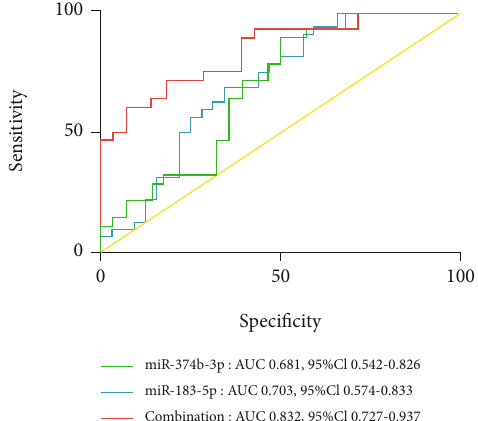
Figure 5: Diagnostic values of miR-183-5p and miR-374b-3p. ROC curve analysis indicated AUCs for miR-183-5p and miR-374b-3p of 0.703 (: 0.574 – 0.833) and 0.681 (95% CI: 0.542 – 0.82), respectively. Combination of miR-183-5p and miR-374b-3p yielded an AUC of 0.832 (95% CI: 0.727 –